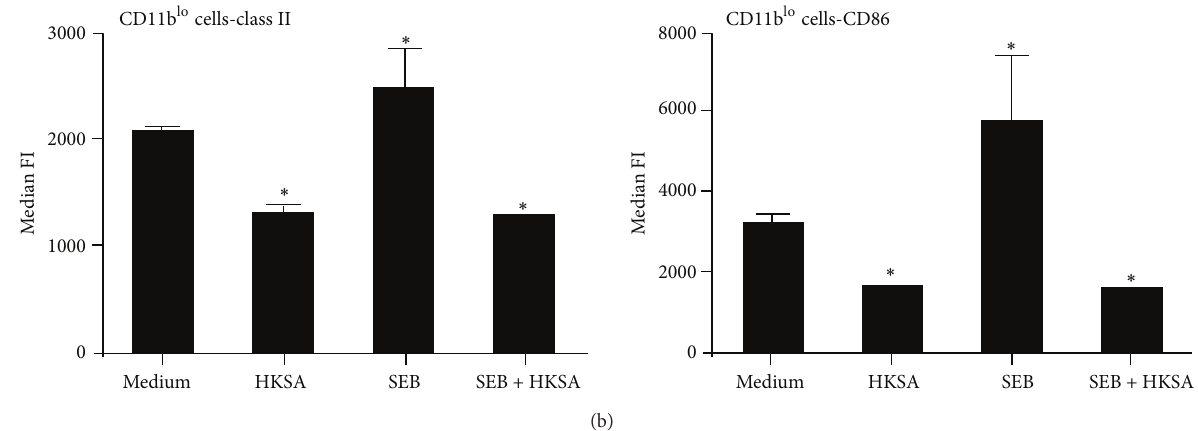
Figure 1: Modulation of expression of HLA-DR3 and CD86 on CD11b + cells by HKSA. Splenic mononuclear cells from HLA-DR3 transgenic mice were cultured with medium, HKSA (10 8 bacteria/mL), SEB (1 𝜇 g/mL), or SEB + HKSA. 24 hours later, the cells were harvested and washed and expression of HLA-DR3 and CD86 on CD11b + cells was analyzed by flow cytometry. Mononuclear cells were first gated based on forward and side scatter profiles. Other analyses were performed on cells within this gate. Representative histogram profiles and bar charts depicting median fluorescent intensity (MFI) are given. Each bar represents mean ± SE from 2 different experiments, each performed in triplicate. ∗ 𝑃 < 0.05 compared to cells cultured with